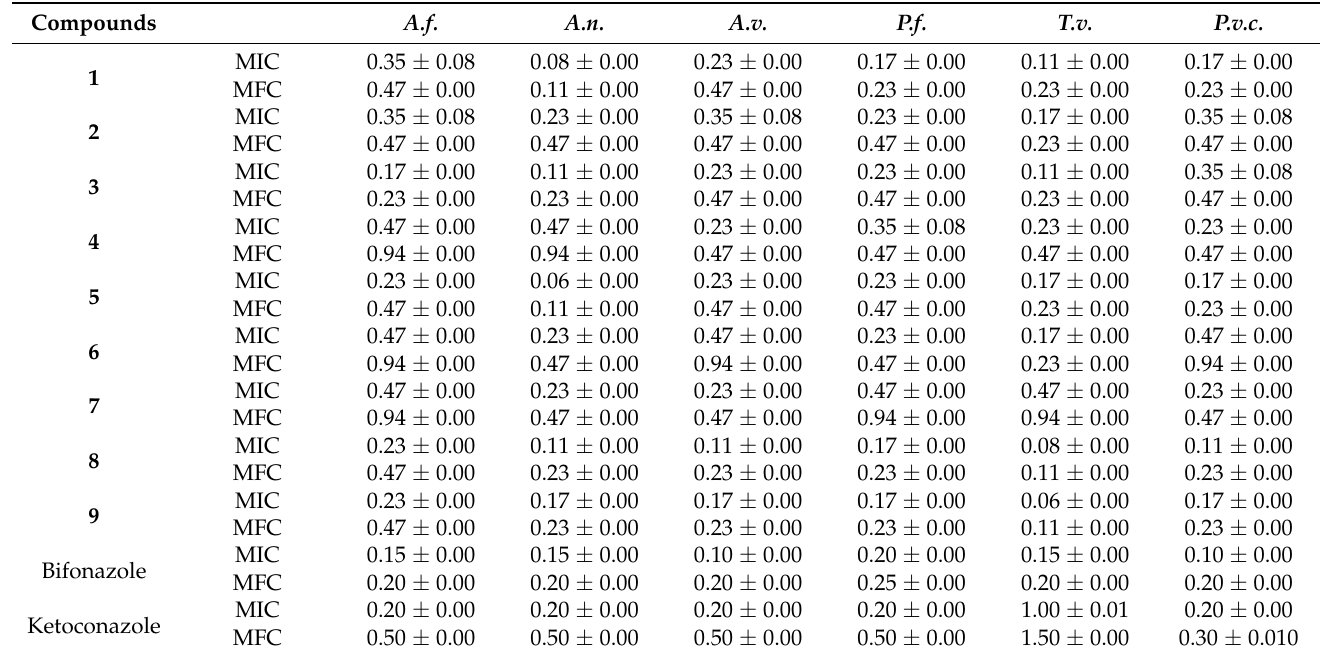
Table 3. Antifungal activity of thiazole derivatives. (MIC and MBC in mg/mL).